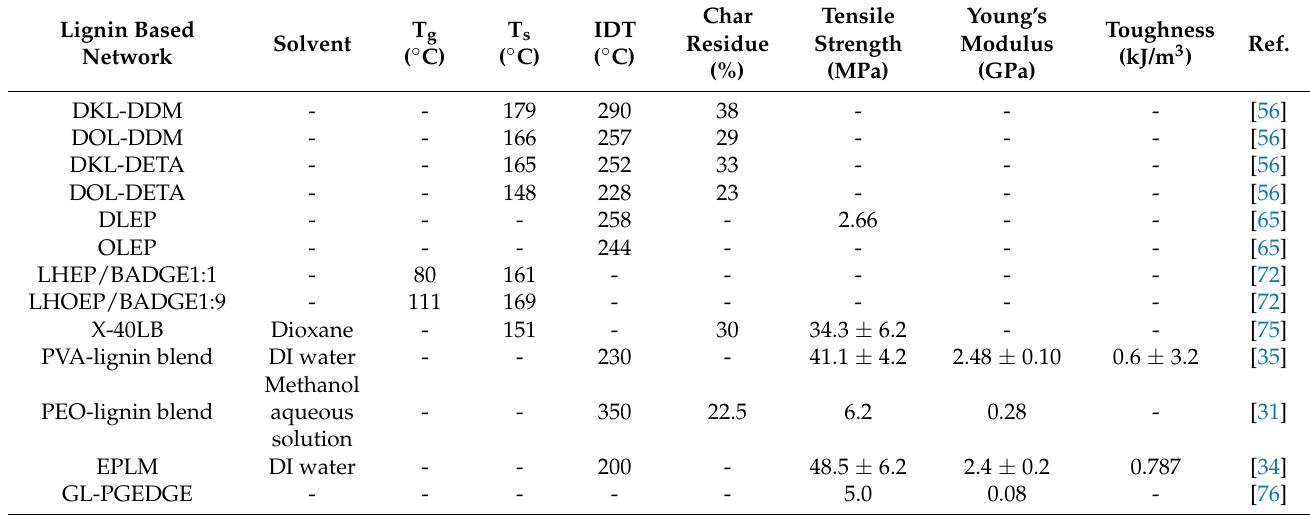
Table 1. A summary of thermal and mechanical properties of the lignin-based